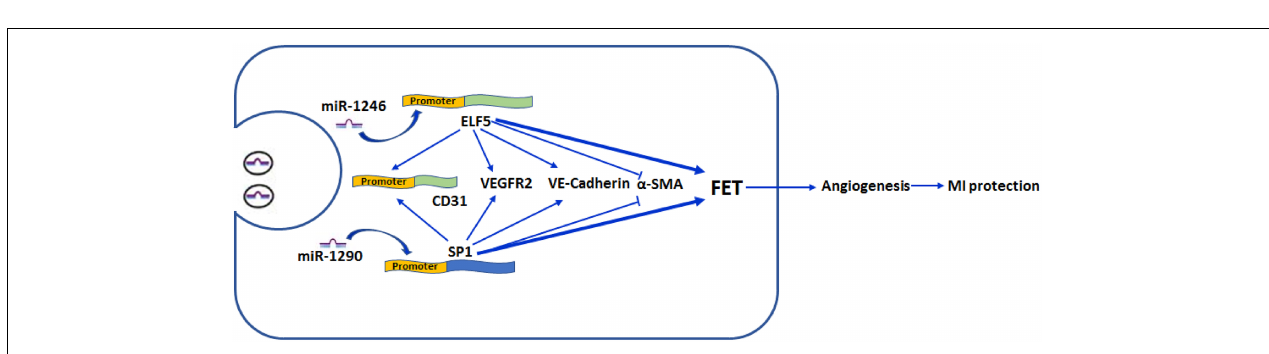
FIGURE 8 | Effects of miR-1246 and miR-1290 in exosomes from EPCs on angiogenesis in rats with myocardial infarction. After administration of PBS to sham and model groups, and of exosomes from EPCs transfected with NC/Exo, Mimics-1/Exo, or Mimics-2/Exo, the expressions of miR-1246, miR-1290, CD31, ACTA2, ELF5, and SP1 were examined by qRT-PCR (A) , the expressions of ELF5, SP1, Lamin A, α -SMA, and CD31 were examined by western blot (B) , and the expressions of ELF5, SP1, α -SMA, and CD31 were also examined by IHC (C) . N = 10. ** P < 0.01 as compared with the Sham group; # P < 0.05, ## P < 0.01 as compared with the Model group. Exo, exosomes; Mimics-1, miR-1246 mimics; Mimics-2, miR-1290 mimics.